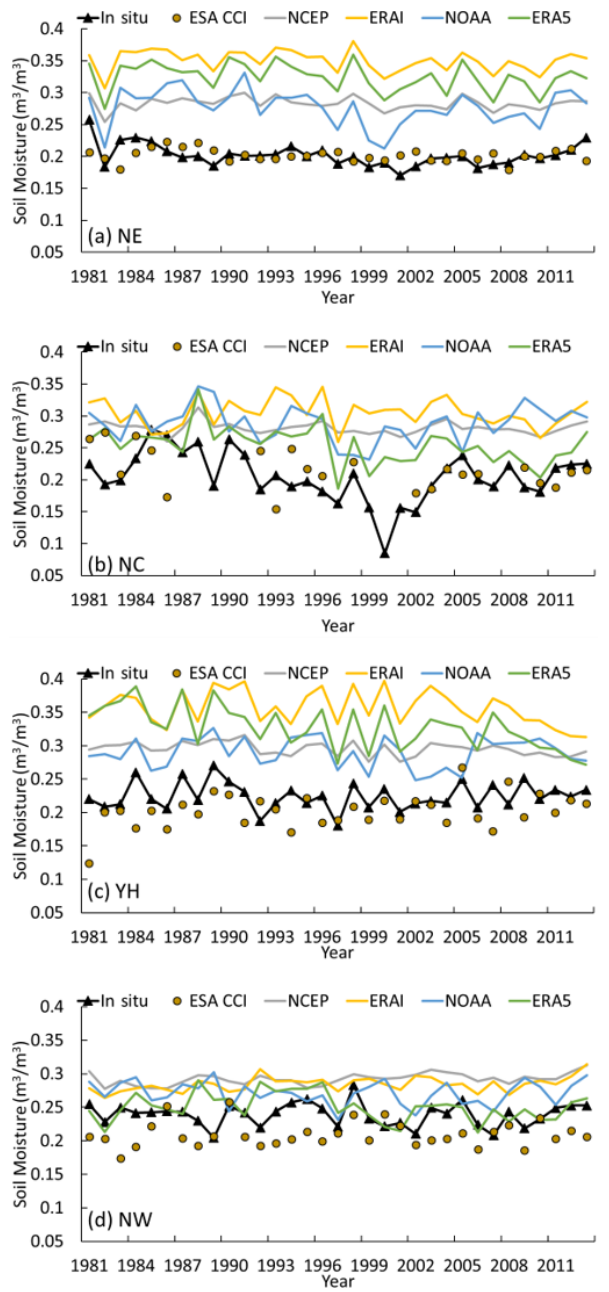
Figure 4. Time series of SM in four research regions (a–d) from 1981 to 2013.